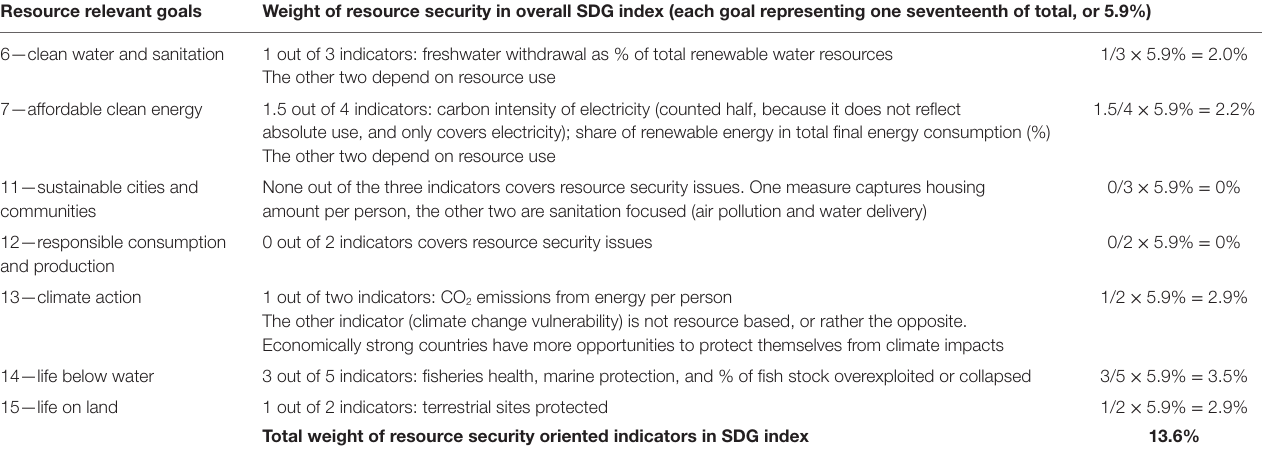
tABLe 1 | Our analysis of the sustainable development goal (SDG) index’s sensitivity to the resource security (or sustainability) dimension of the metric. resource relevant